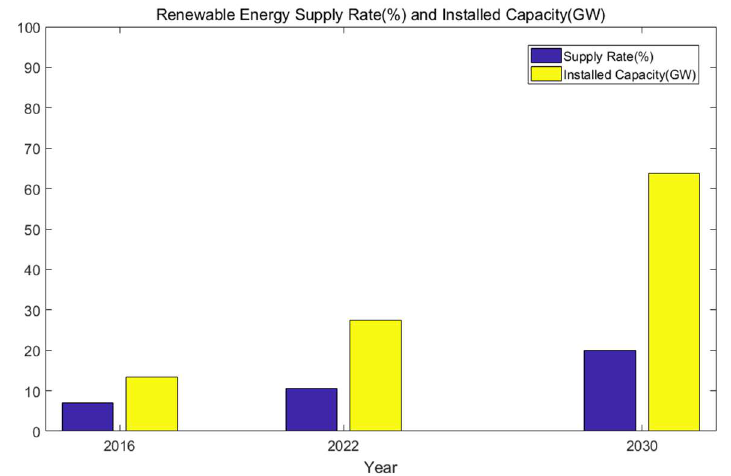
Figure 2. Renewable energy supply target in 3020 planning for renewable energy [9].